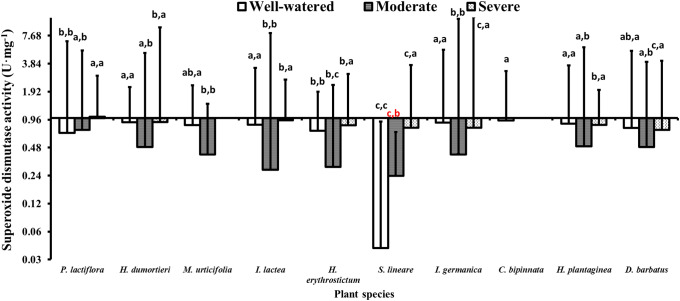
Variance of superoxide dismutase activity in the ten species during the drought stress tests.The histogram shows the mean values. Above the histogram, the lowercase letters before the commas indicate statistical significance among the different plant species, and the lowercase letters after the commas indicate statistical significance among the well-watered, moderate and severe drought stress treatments. The different lowercase letters indicate a significant difference at P< 0.05.